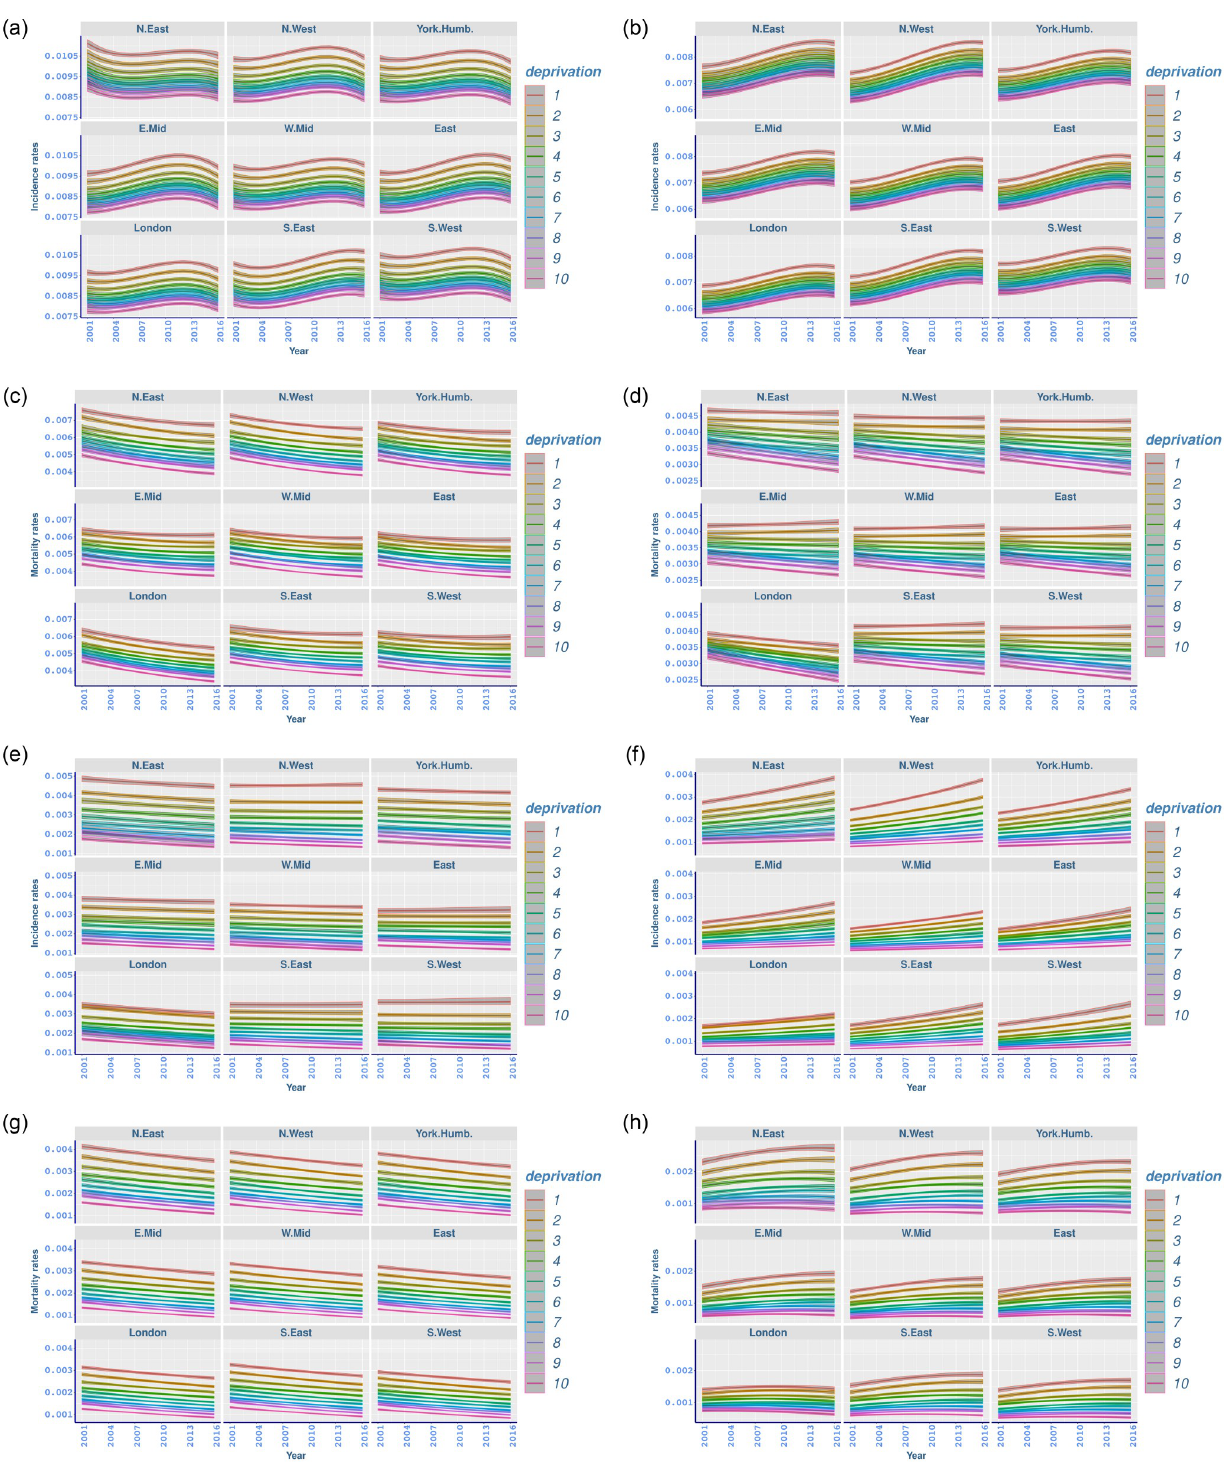
Fig 1. Age-standardised fitted incidence and mortality rates (with 95% credible intervals) for all-cancer, and lung, trachea and bronchus cancer, between 2001 and 2016 for different deprivation deciles and regions in England. (a) Male all-cancer incidence; (b) Female all-cancer incidence; (c) Male all-cancer mortality; (d) Female all-cancer mortality; (e) Male lung cancer incidence; (f) Female lung cancer incidence; (g) Male lung cancer mortality; (h) Female lung cancer mortality.